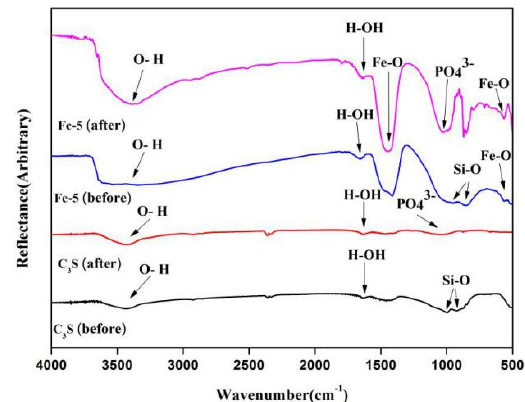
Figure 6. FT-IR spectra of C 3 S and Fe / C 3 S powders before and after immersing in SBF solution for seven days.